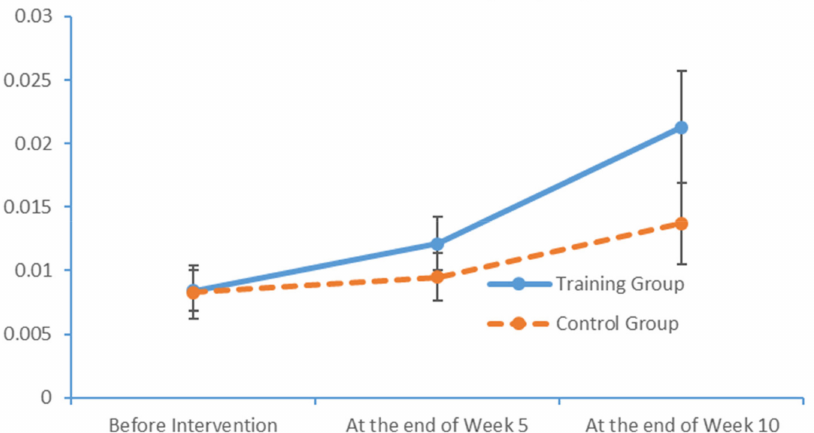
Figure 15. Changes in the power values of the beta_region_front wavebands measured in the two subject groups at several time